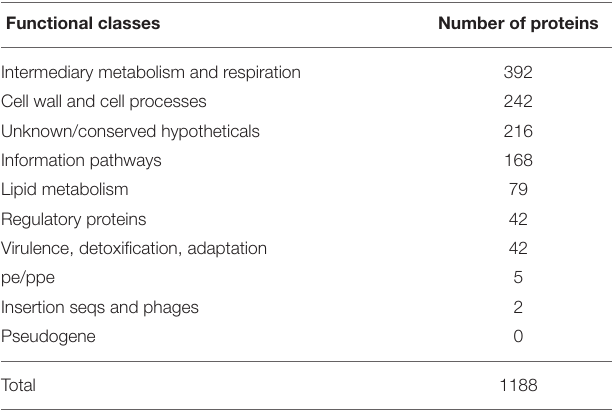
TABLE 2 | The distribution of the number of proteins with conserved functional classes in the two mycobacteria. Functional